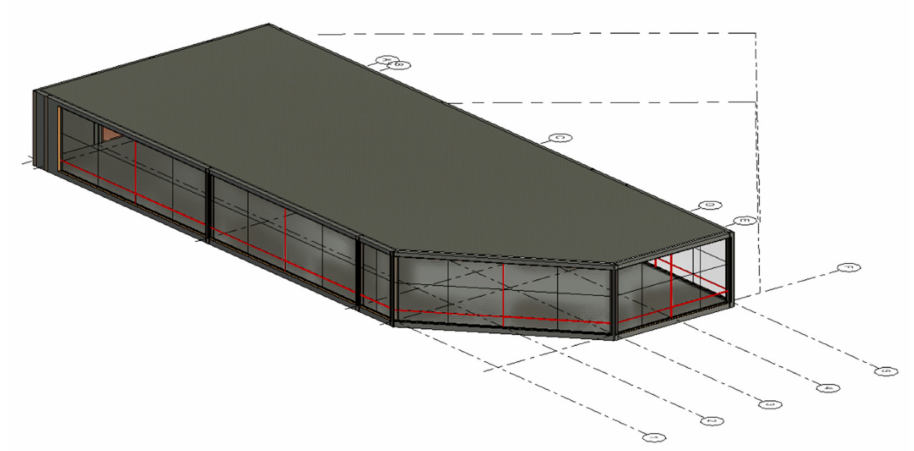
Figure A1. Case Study—Diamond shape BIM model.